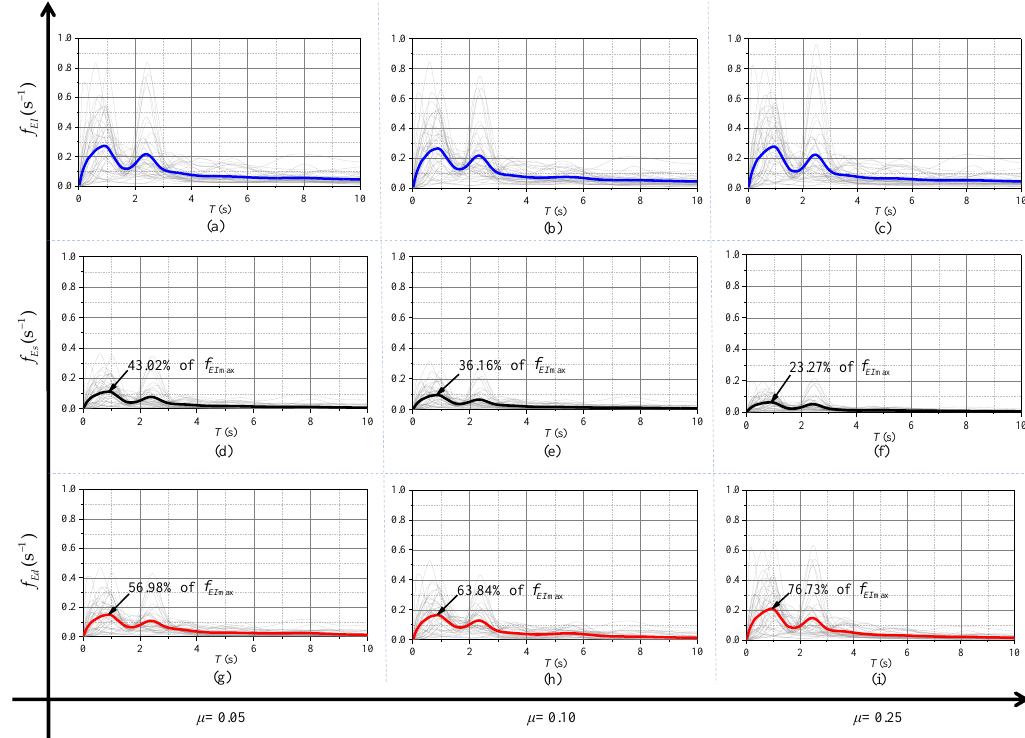
Figure 17. Seismic-induced energy spectra of SDOF element connected to the TVMD.